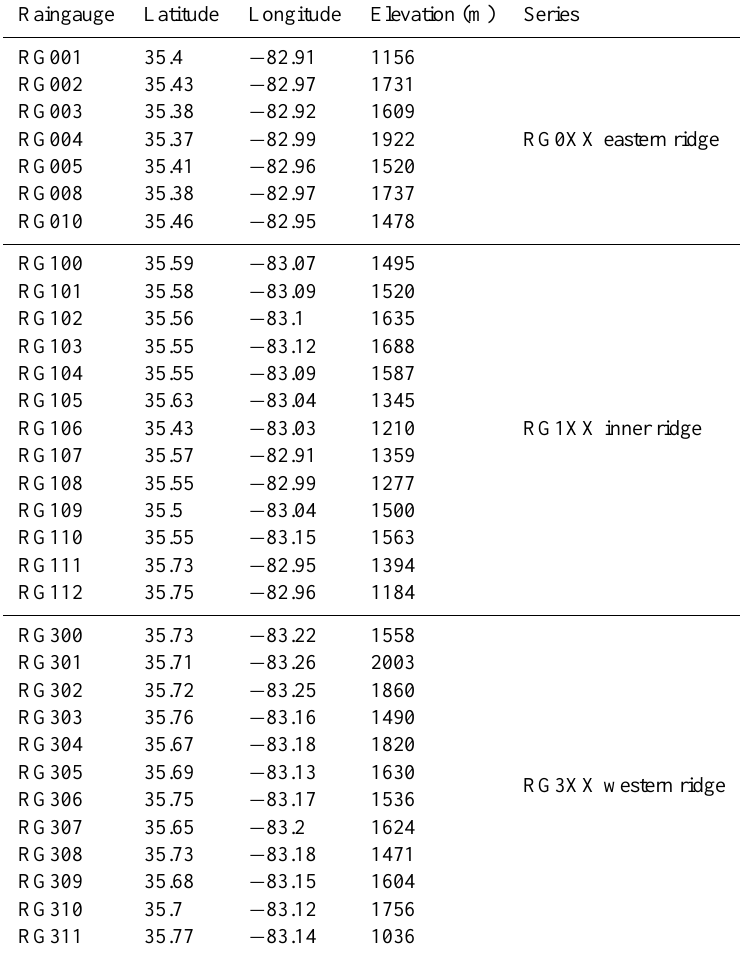
Table 1. Inventory of long-term raingauges in the Pigeon River basin including the Great Smoky Mountains National Park (GSMNP) in the southern Appalachians used in this